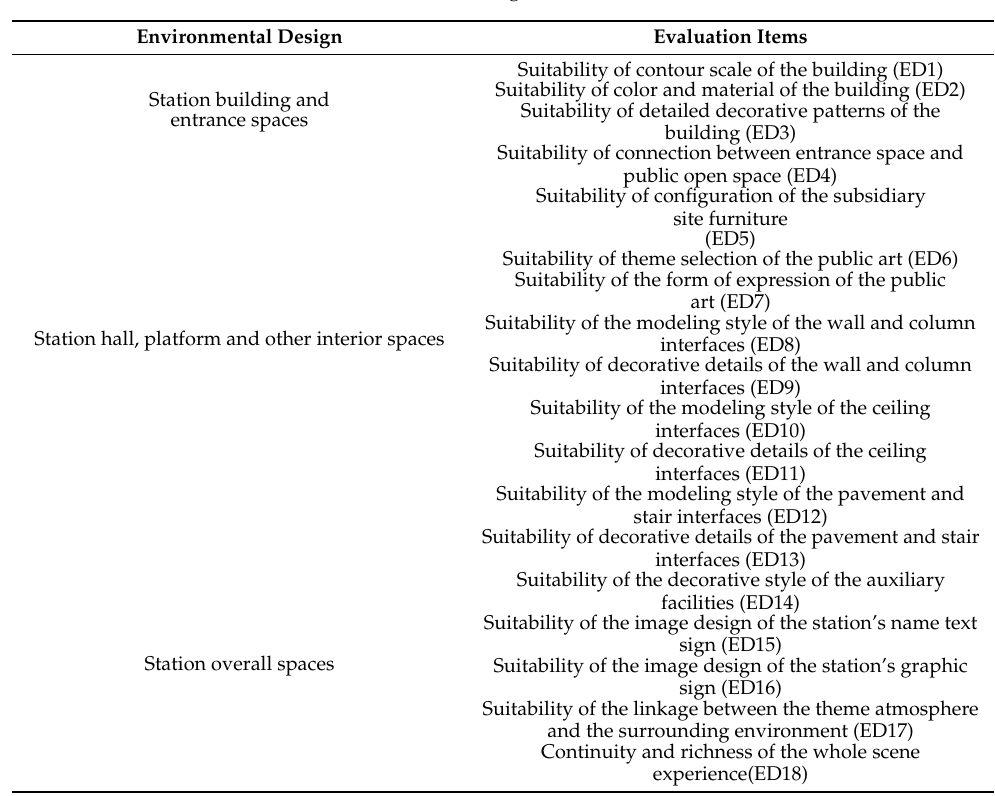
Table 4. Evaluation indexes of environmental